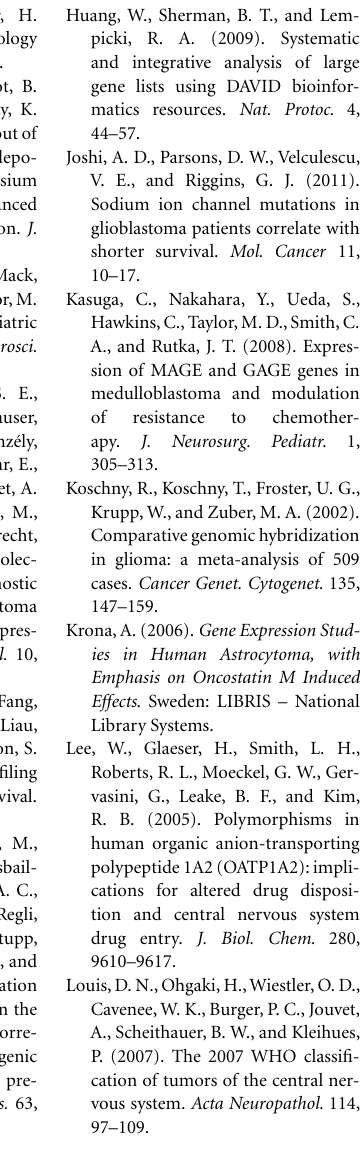
Table S3 | Functional annotation analysis from differentially overexpressed genes. FAA performed using NIH-DAVID software (version 6.7, http://david.abcc.ncifcrf.gov/) on the differentially overexpressed genes reported inTable S1 in Supplementary Material.We used the parameter